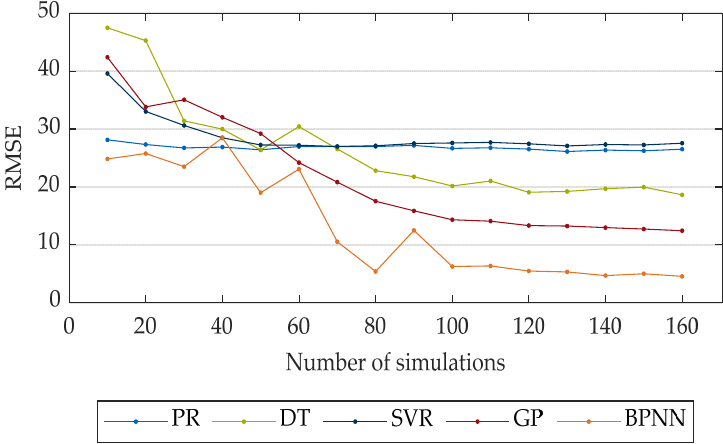
Figure 14. RMSE scores for the test sets as a function of the data volume for Use Case 2.